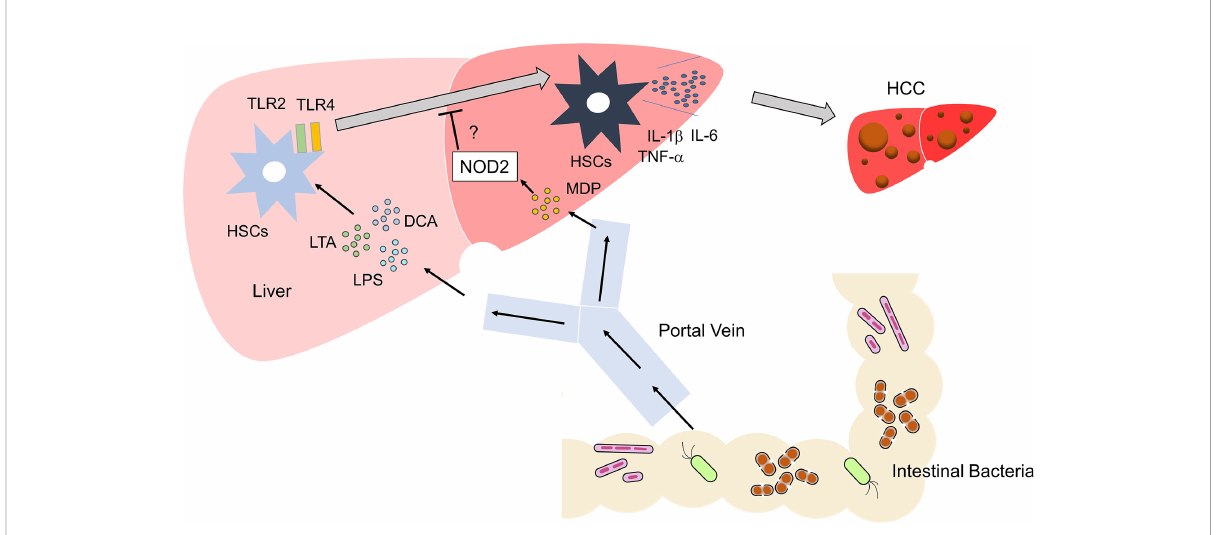
FIGURE 3 Activation of TLRs and NOD2 in the development of liver cancer Microbe-associated molecular patterns (MAMPs), including lipopolysaccharide (LPS) and lipoteichoic acid (LTA), enter the liver via the portal vein. These MAMPs activate TLR2 and TLR4 in hepatic satellite cells (HSCs). Metabolites such as deoxycholic acid (DCA) act together with TLR2 and TLR4 ligands to induce differentiation of HSCs with a senescence- associated secretory phenotype (SASP). HSCs with SASP produce large amounts of IL-1 b , IL-6, and TNF- a . Differentiation of regular HSCs into those with SASP promotes the development of HCC. Activation of NOD2 by MDP might inhibit the development of HCC through its negative regulation of TLR2 and